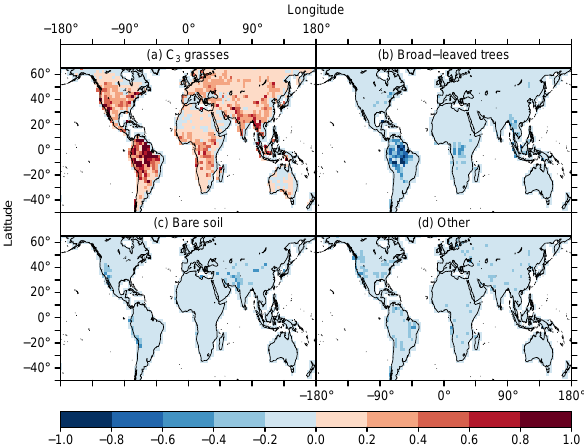
Fig. 1. Change in grid cell fraction of UM-UKCA land surface types between present day (2000) and the anthropogenic land use scenario (cropland expansion) for 2095 (2095–2000). Changes in the crop fraction (assigned to C 3 grasses) were calculated using the IMAGE 2.1 model (Alcamo, 1999).